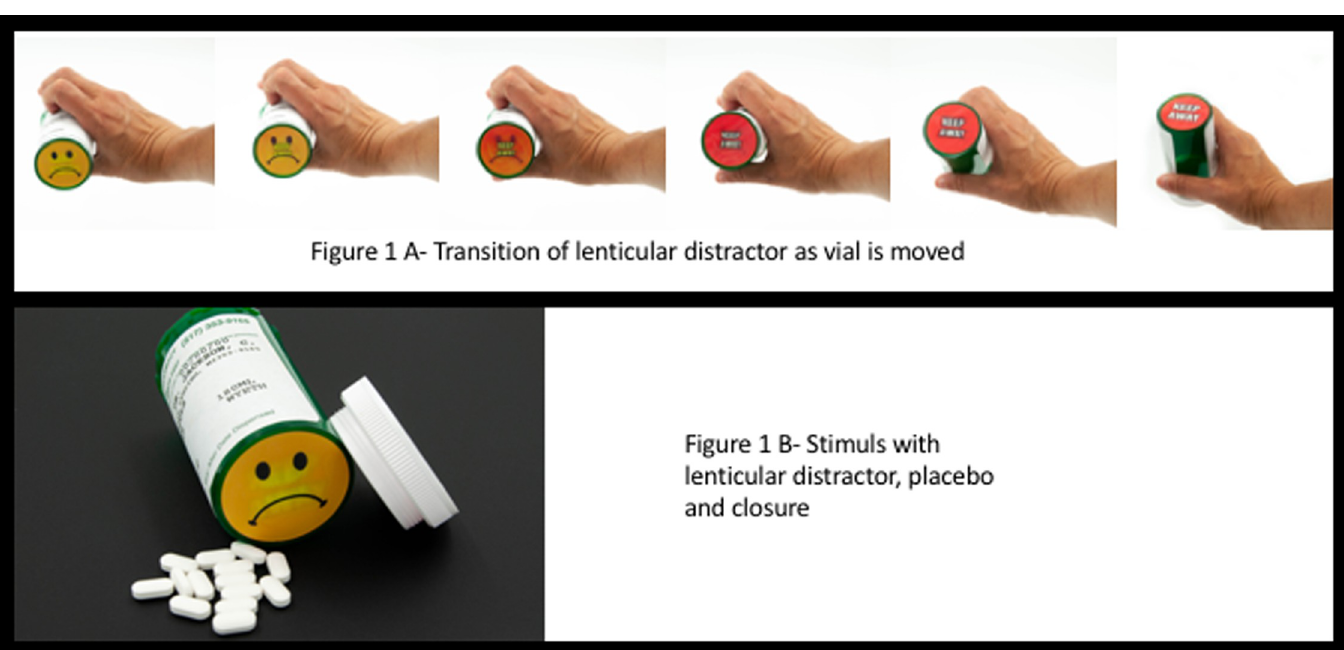
Fig 1. The visual distracter consisting of a lenticular graph designed to depict a schematic facial icon (1.A, unhappy face) or warning sign (1.B) depending on perspective and motion. Note that as the package is moved, the distracter changes in color and format from 1.A to 1.B and back.